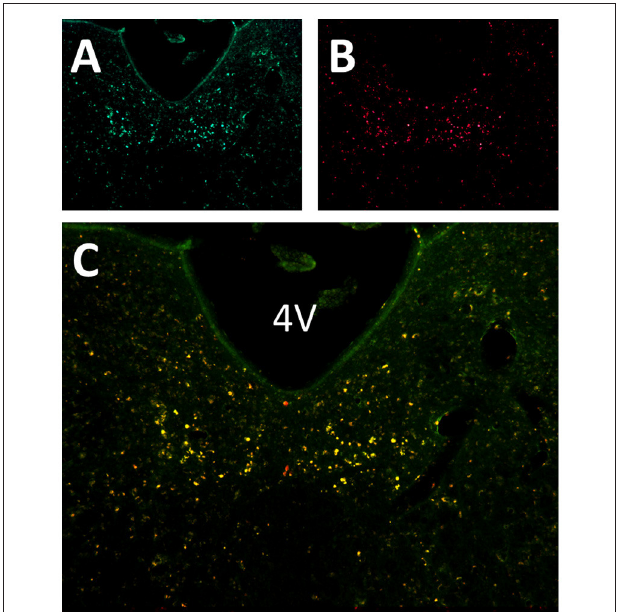
FIGURE 2 | Localization of AAV5-hSyn-hM4 (Gi)-mCherry and fluorescently labeled cholera toxin B (CTB-AF488) in the hypoglossal nucleus. Fluorescent microscopy images ( × 20) shows (A) CTB labeled motoneurons within the rostral hypoglossal nucleus following genioglossal injection; (B) mCherry expression in the same section; (C) merged mCherry and AF488 images. 4V denotes 4th